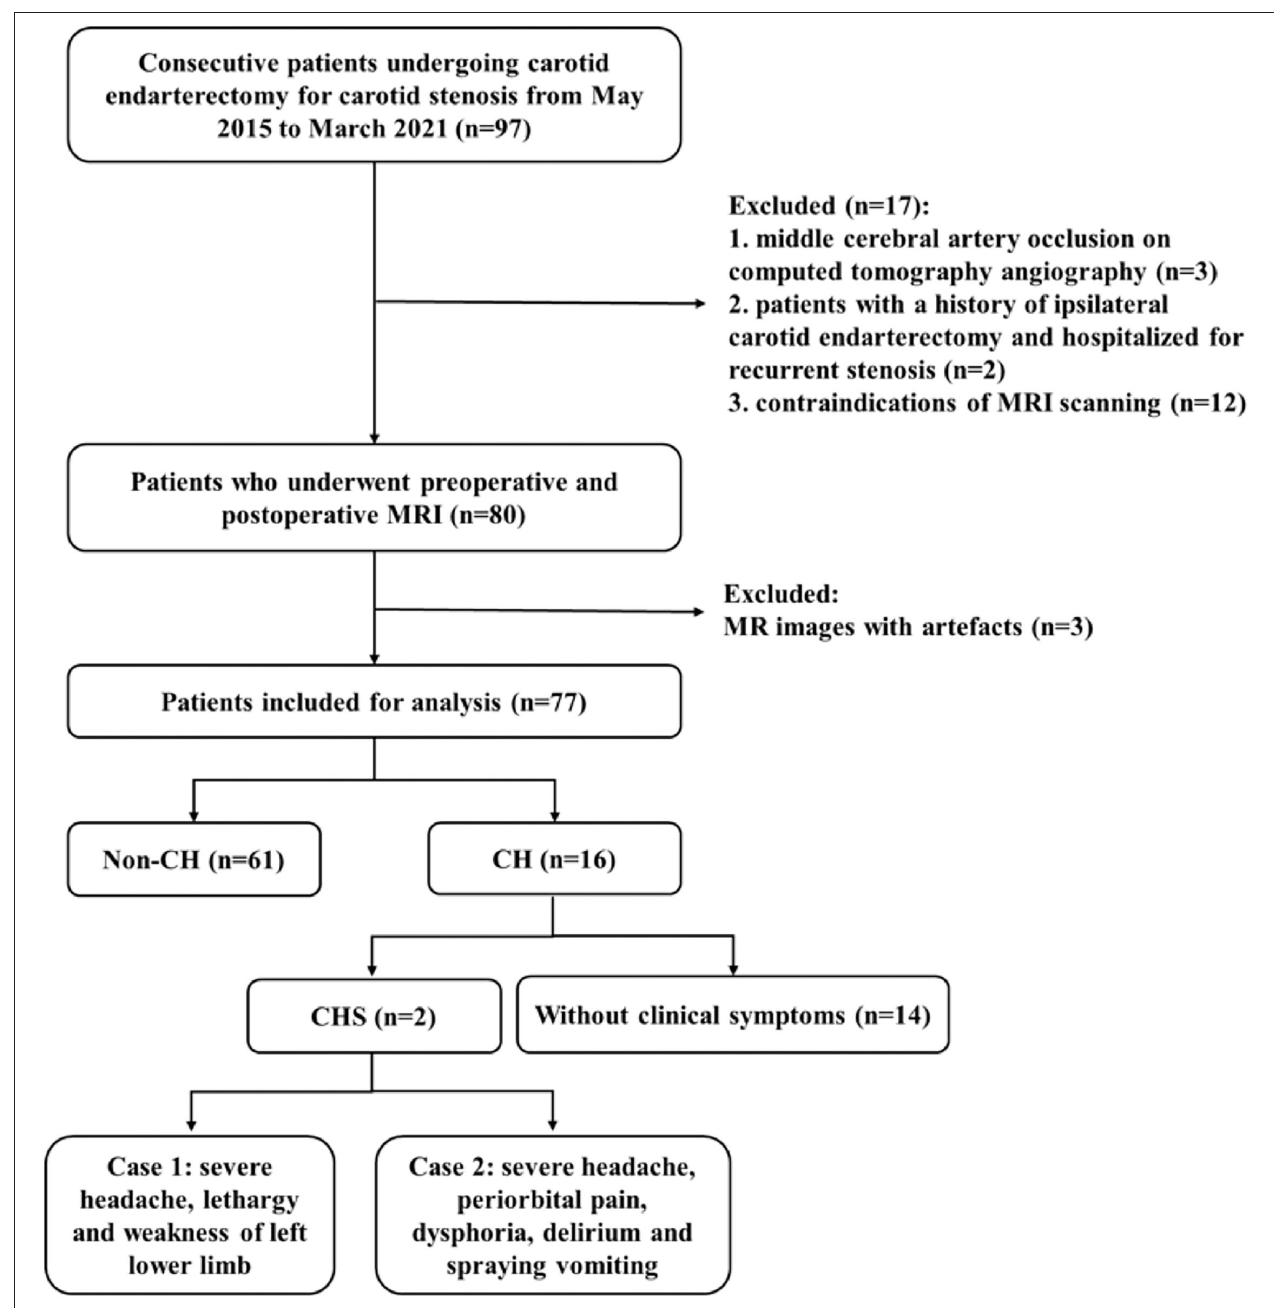
FIGURE 1 | Flowchart of patient